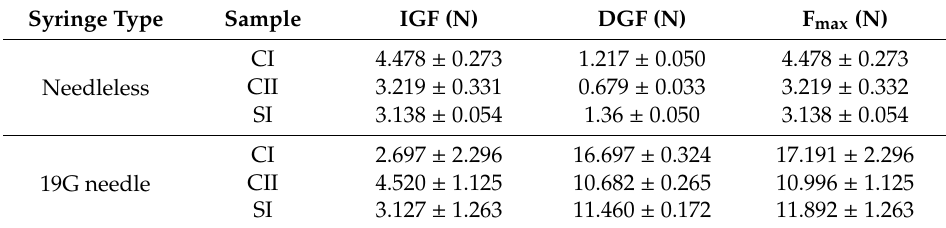
Table 3. Injectability force measurements of hydrogel solutions by 10 mL syringe (BD, tip inner and outer diameter of 2 and 4 mm, respectively) with and without a needle (19G × 1 1/2” 1 × 40mm). Initial glide force (IGF), dynamic glide force (DGF) and maximum force (F max ) values were counted as mean of three experiments ( n = 3) with standard deviations in Newton (N) unit.